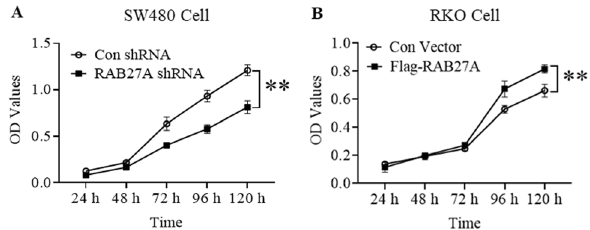
Figure 2. The effect of RAB27A on the proliferation of colon cancer cells. ( A ). RAB27A knockdown suppresses the proliferation of SW480 cells. The RAB27A knockdown and the negative control SW480 cells were seeded in 96-well plates, and cell proliferation was measured by using CCK-8 assay kit. ( B ). RAB27A overexpression promotes RKO cell proliferation. The RAB27A overexpression RKO cells and the negative control cells were seeded in 96-well plates, and cell proliferation was measured by using CCK-8 assay kit. The optical density (OD) value was shown as mean ± S.D. (n = 3), and analyzed by two-tailed t -test. ** P < 0.01 . All the experiments were repeated three times independently and the representative results were